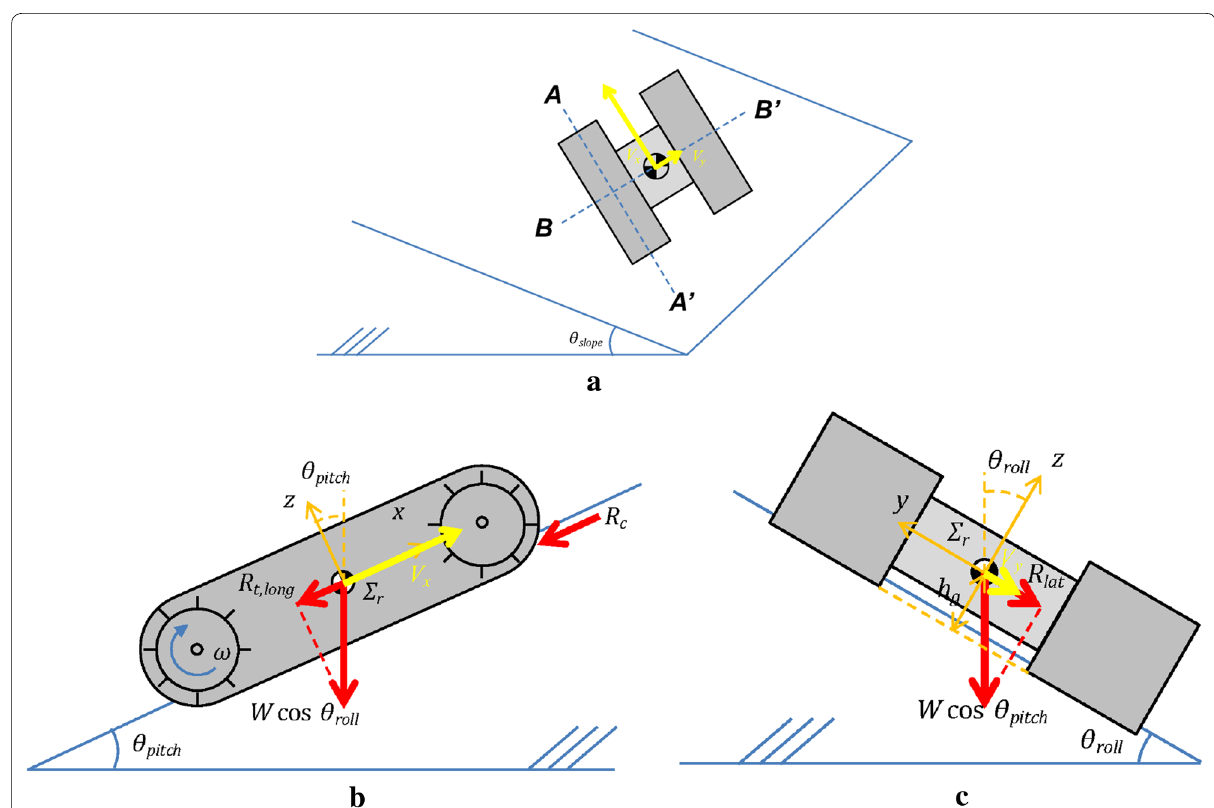
Slip model for straight motion Longitudinal slippage is expressed as a slip ratio, and lat- eral slippage is expressed as a slip angle. These slips can be derived using the force model and soil mechanics.